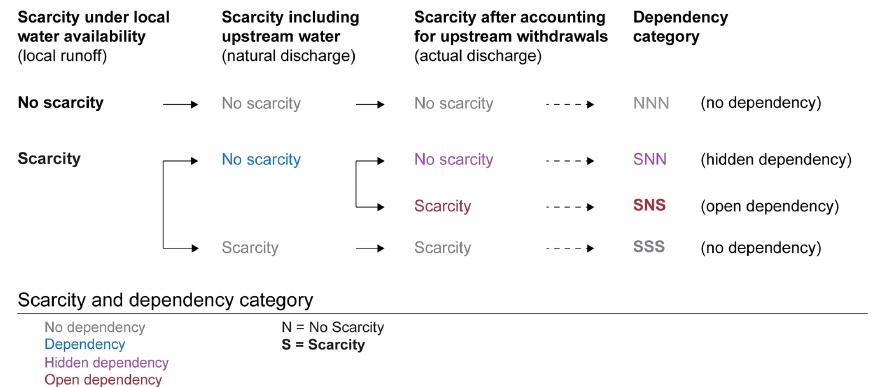
Figure 4. Definition of potential upstream water dependency categories. Dependency categories are obtained by summarising three letter codes representing the scarcity category using local runoff, natural discharge, and actual discharge respectively (see definitions in Table 1).